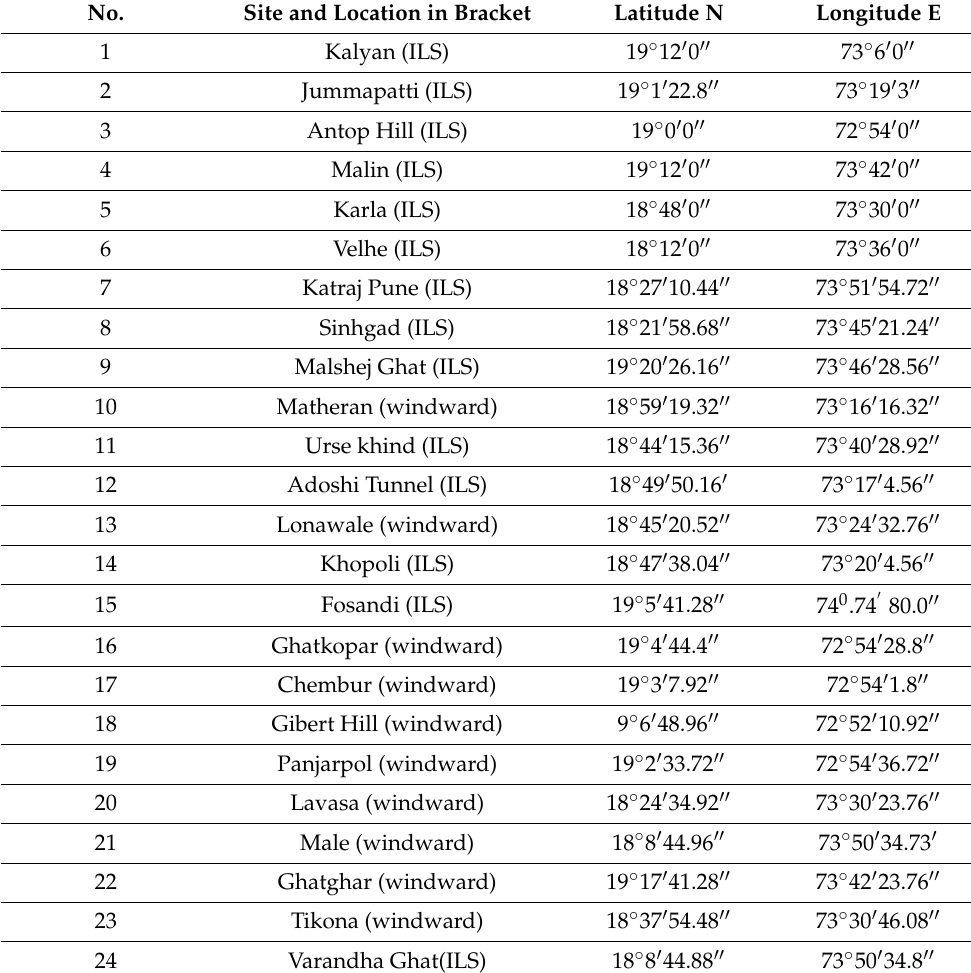
Table 3. Locations of LS-prone sites in the Mumbai-Pune region. The words windward, ILS and DLS indicate the locations of LS sites on the windward, immediate leeward and distant leeward sites, of the WG mountains,